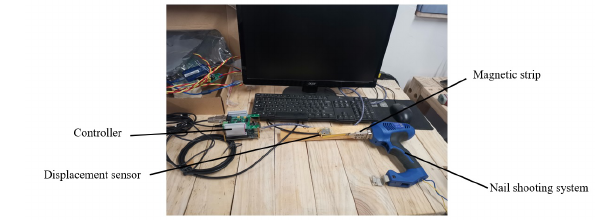
Fig. 18. Nail shooting system test system.